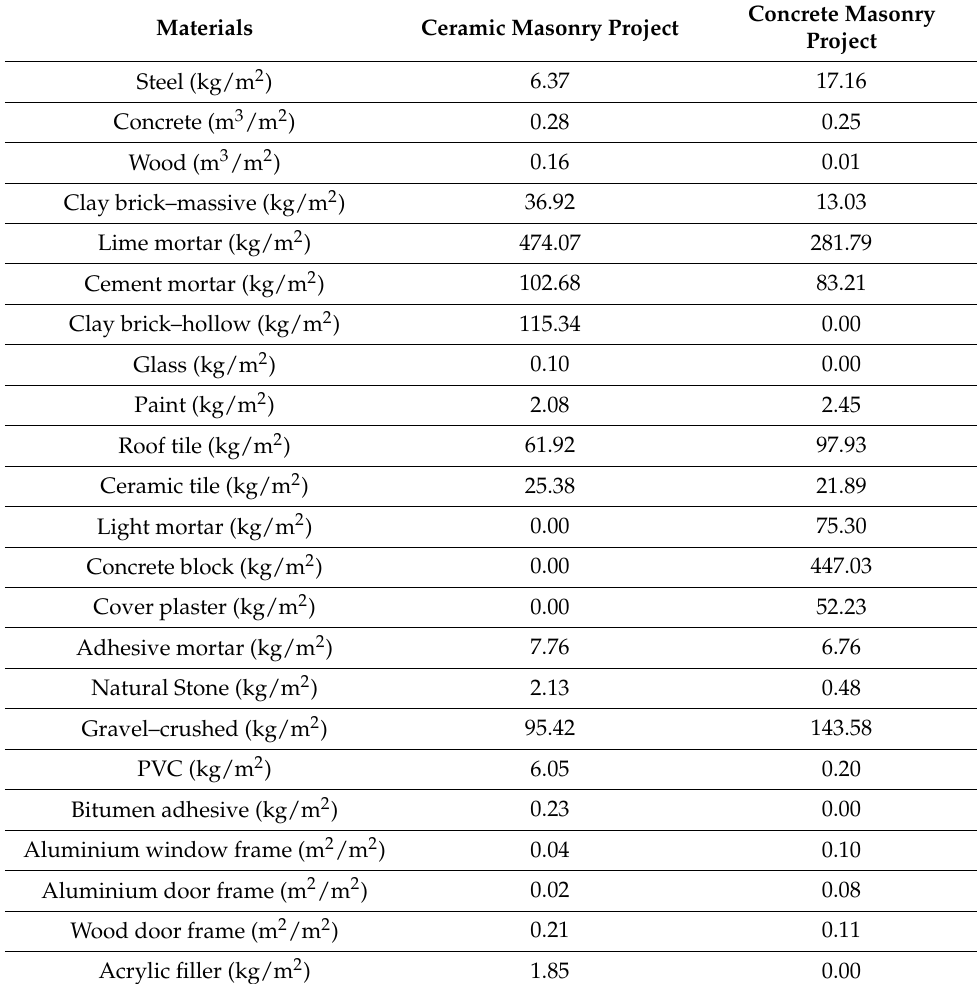
Table 6. Ceramic masonry ceramic masonry and concrete masonry projects’ LCI for the defined functional unit.